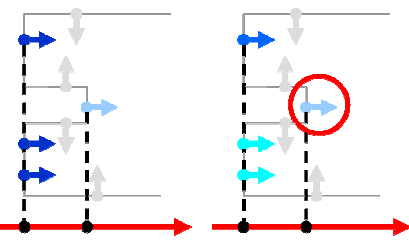
Figure 6. Clustering refinement method in detail. Left: the value of the three points (blue arrows) projected on the axis (red) is equivalent, these points are thus clustered as one wall. These points should however be clustered as two walls. Right: when points of different values on the axis (marked with the red circle) are found between clustered points, then these points are clustered as two different walls (turquoise and blue arrows).